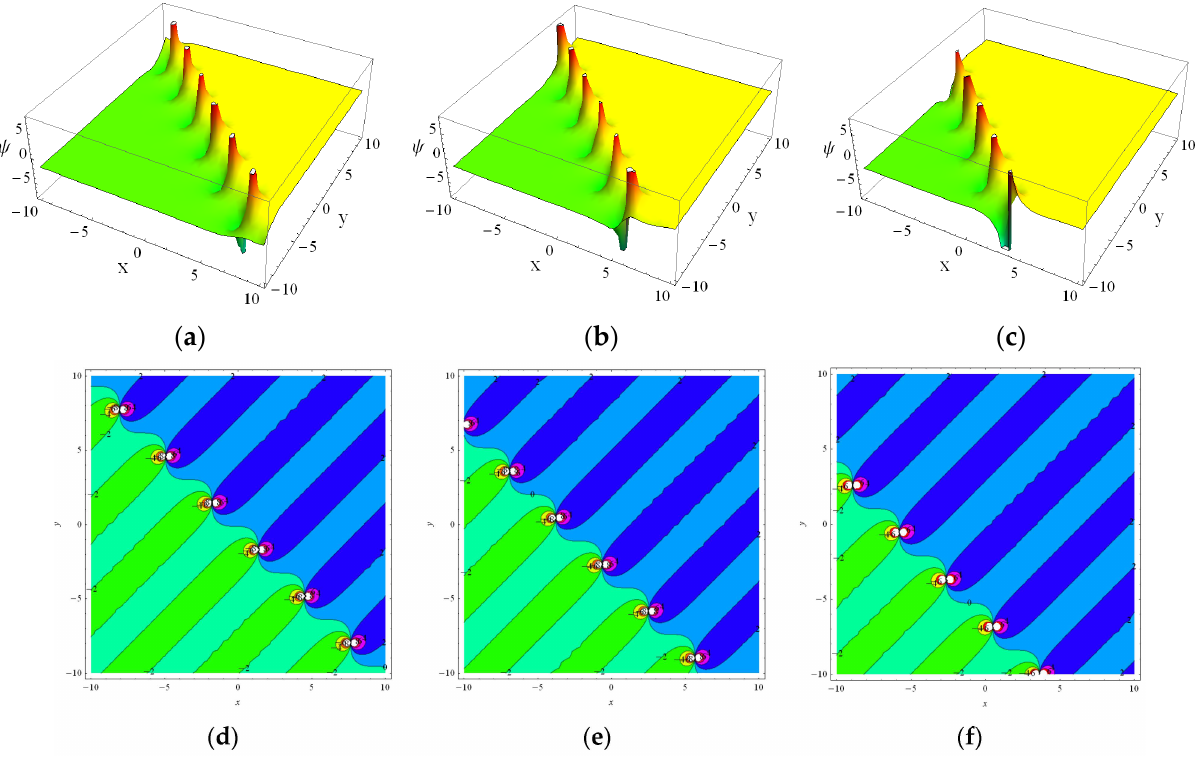
tively. We can find the waveform of Equation ( 26 ) is the dark wave and of Equation ( 27) Figure 3. The 3-D plots and 2-D contours of Equation (16) with the parameters as ε 3 = 1, ε 4 = 1,